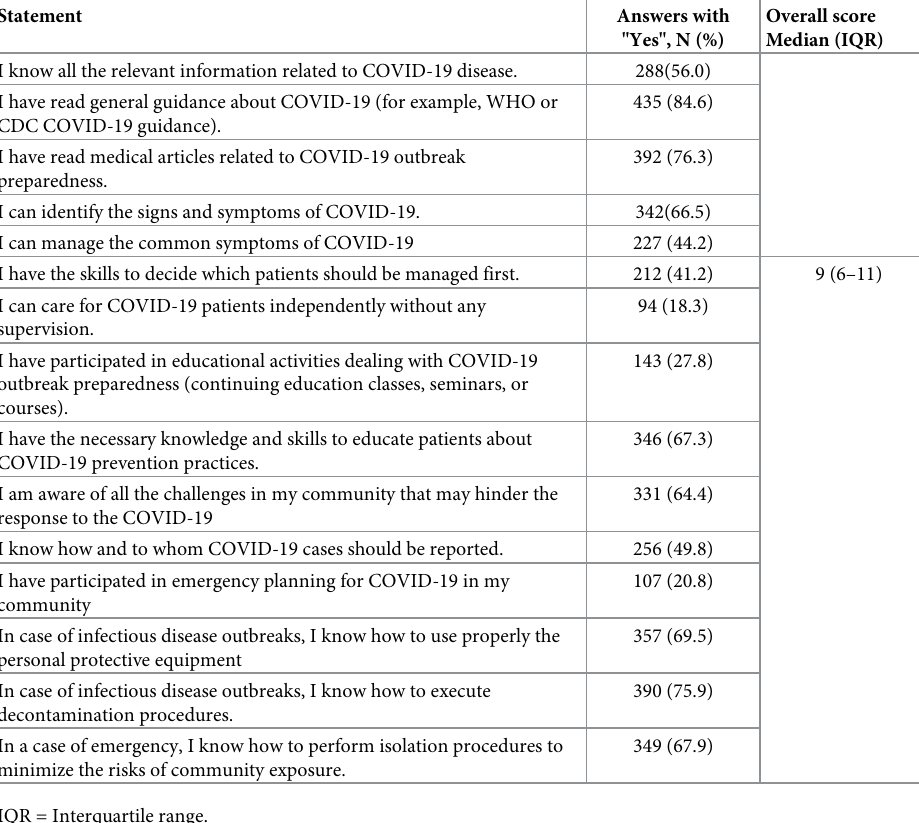
Table 3. Self-preparedness of HCWs for the COVID-19.